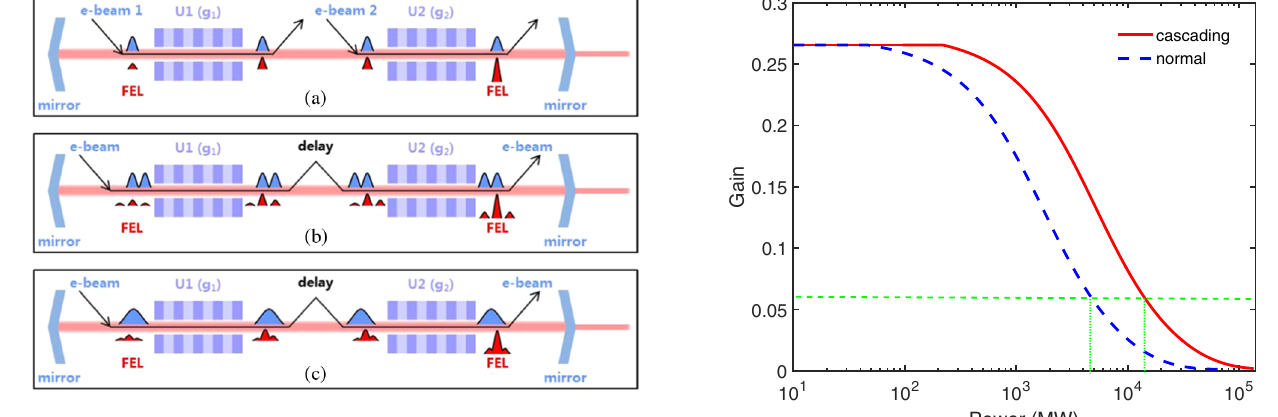
FIG. 1. Schemes for gain cascading in single-pass of FEL oscillators. (a) The original idea conceptually to replace the degenerated electron bunch with a fresh one. (b) A more practical method of using bunch trains and refresh it through the delay between the two stages of undulators. (c) The bunch trains are replaced by a single long electron beam.